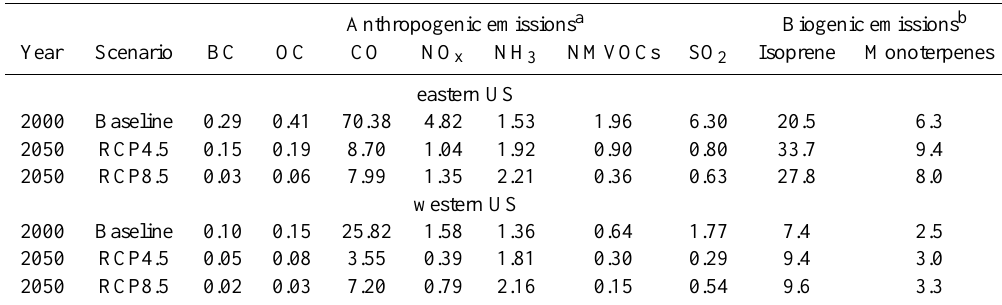
Table 2. Anthropogenic short-lived air pollutants and biogenic emissions in 2000 and 2050, projected by the RCP4.5 and RCP8.5 scenarios over the United States.